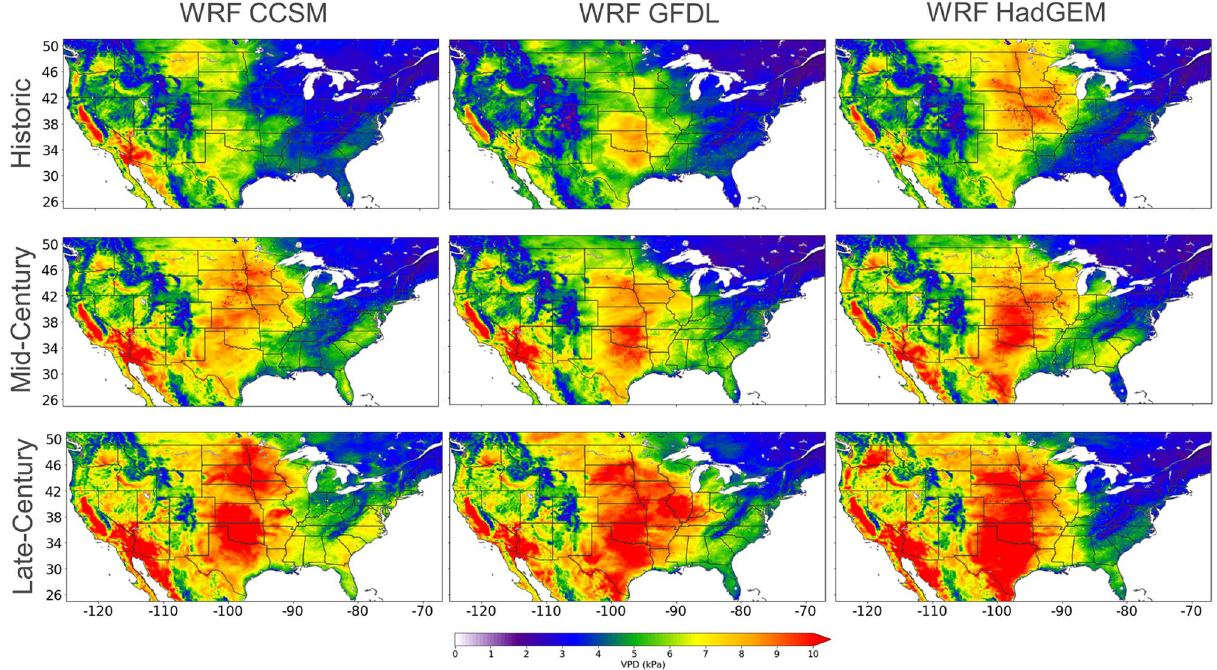
Figure 3. Spatial comparison of decadal averaged annual maximum VPD: 1995–2004 (Historic), 2045–2054 (Mid-Century) and 2085 -2094 (Late-Century). VPD is calculated with WRF CCSM (left column), WRF GFDL (middle column) and WRF HadGEM (right column). This figure was generated using the Matplotlib 41 library for the Python programming language (https:// matpl otlib.